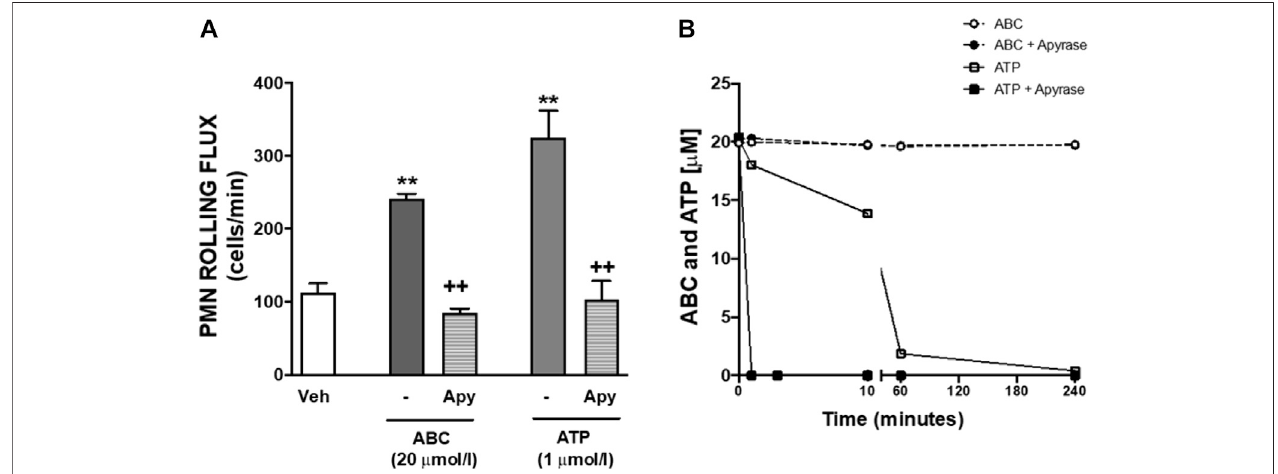
FIGURE4| EffectsofapyraseonPMN-endothelialcellinteractionsandonlevelsofABCandATP. (A) HUVECandPMNwereincubated(4 h)withABC(20 µmol/L), ATP (1 µmol/L) or vehicle (veh). In some cases, both cell types (HUVEC and PMN) were pretreated with apyrase (Apy, ATPase, 100 μ mol/L, 60 min)priortoABCor ATP treatment. PMN rolling fl ux was quanti fi ed. (B) PMNs were incubated with ABC (20 µmol/L) or ATP (1 µmol/L). In some other experiments, cells were pretreated with apyrase(100UI/L)andlevelsofABCandATPinthesupernatantswerequanti fi edbyHPLC(at0,1,10,60and240 min).Resultsaremean ± SEM,Veh: n (cid:2) 15,ABC 20: n (cid:2) 15,ABC20+Apy: n (cid:2) 9,ATP1: n (cid:2) 6,ATP1+Apy: n (cid:2) 4.** p < 0.01vs.correspondingvalueinvehicle-treatedgroup.++ p < 0.01vs.correspondingvalueinABC or ATP-treated group (ANOVA followed by Newman-Keuls